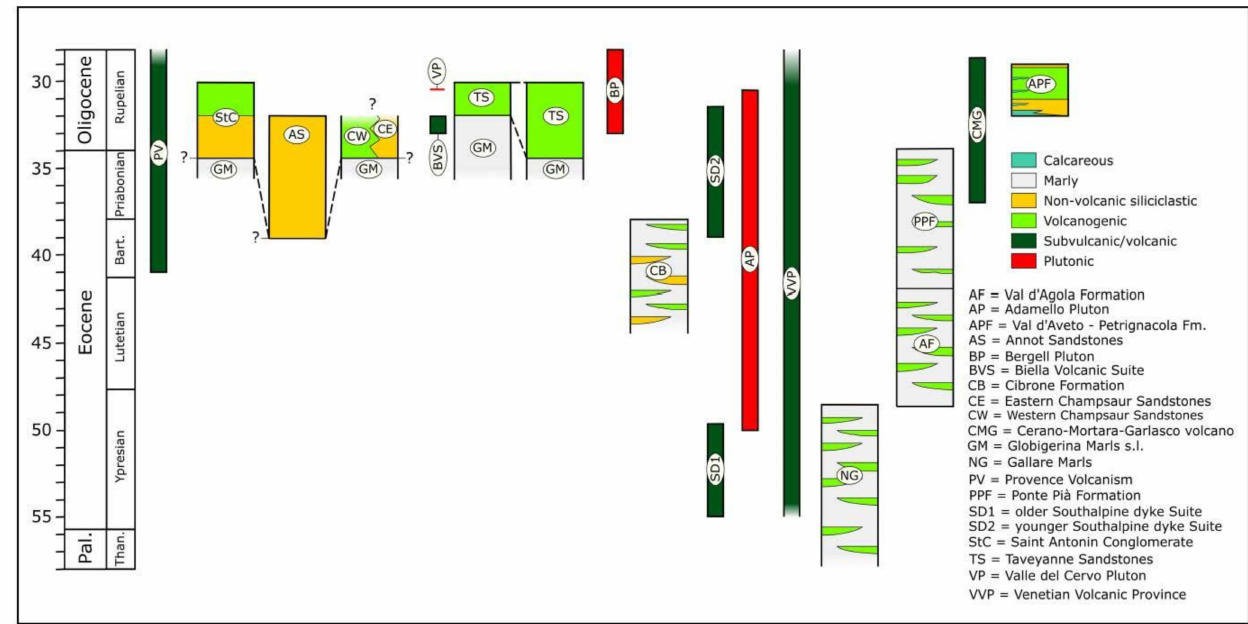
Figure 2. Magmatic manifestations and general stratigraphy of the sedimentary sequences included in the Northern Alpine Foreland Basin, Adriatic Foredeep and Northern Apennine Foredeep. Data from [1,2,5,9,11,26,30–37]. Shade sides mean that no temporal constraints are